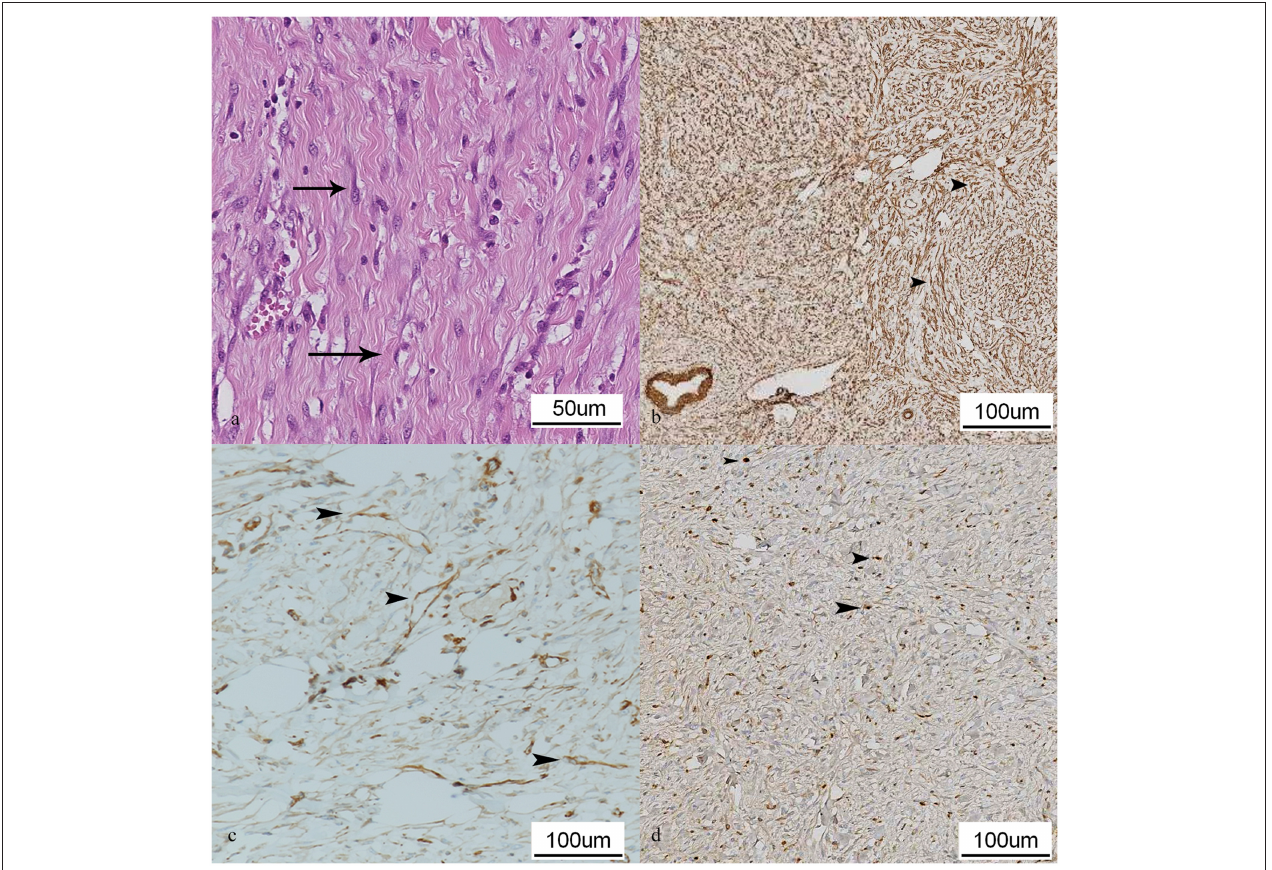
FIGURE 2 | Paratesticular tissue, dog. (a) Histopathological study of the sample. Proliferation of loose connective tissue composed of fusocellular cells with slight atypia (arrows). Hematoxylin and eosin (HE). (b) Actin immunohistochemical stain. This stain highlights the presence of numerous cells which show a fusiform morphology (arrowheads). (c) Ki67 immunohistochemical stain of the lesion. Presence of fusiform cells expressing this marker, indicating cell proliferation (arrowheads). (d) Vimentin immunohistochemical stain in which it is observed several immunolabeled cells disposed with diffuse pattern and morphology that points to a mesenchymal origin